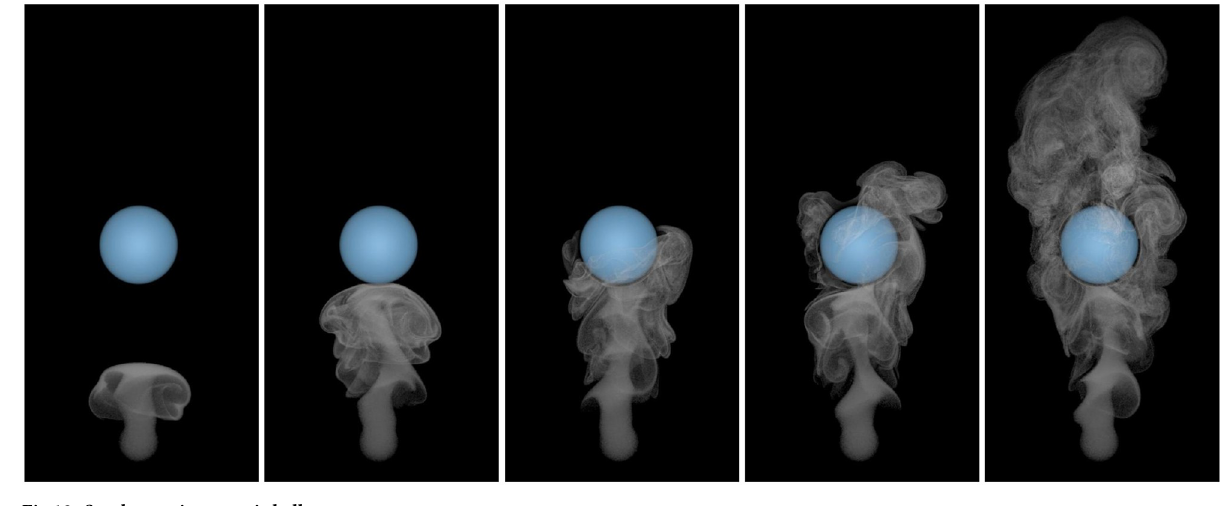
Fig 12. Smoke passing a static ball.